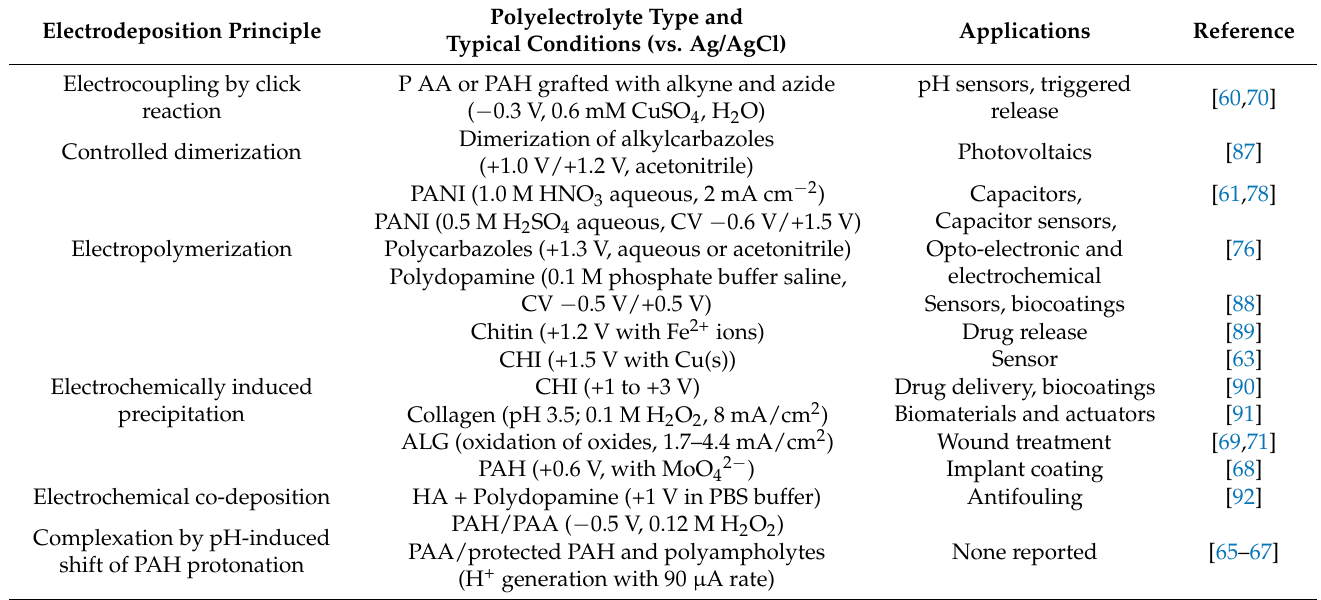
Table 3. Typical electrodeposited systems based on weak polyelectrolytes and emerging applications. Polyelectrolyte Type Electrodeposition Principle